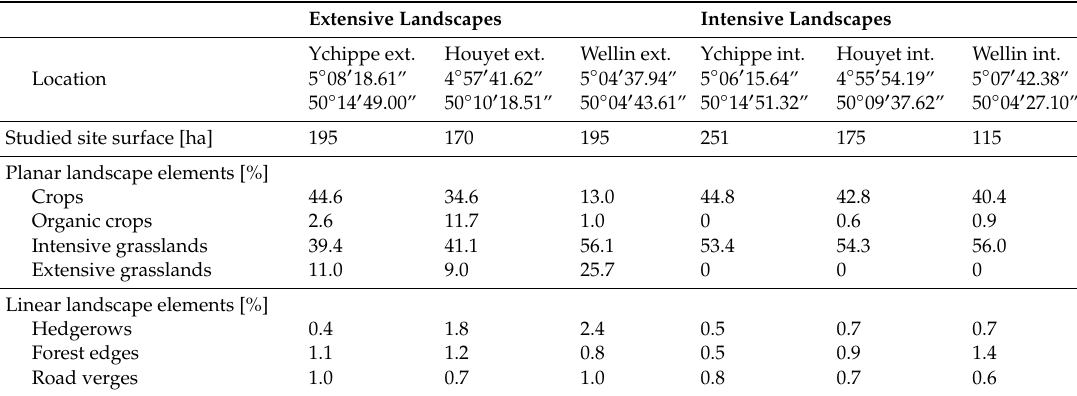
Table 1. Studied site surfaces, coordinates and proportions of the main landscape elements of the six agricultural landscapes studied. (ext., extensive; int., intensive). Extensive Landscapes Intensive Landscapes Ychippe ext. Houyet Location